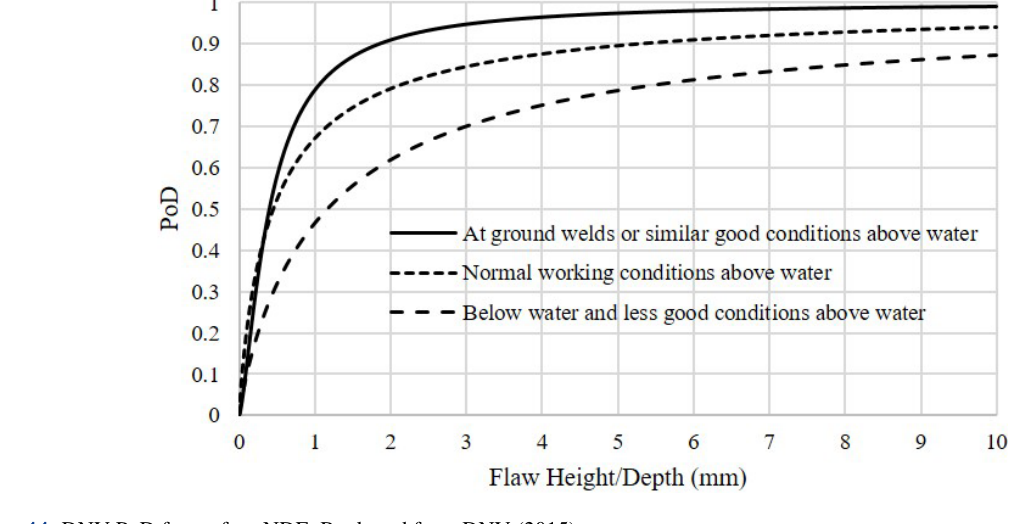
Figure 11. DNV PoD for surface NDE. Replotted from DNV (2015).